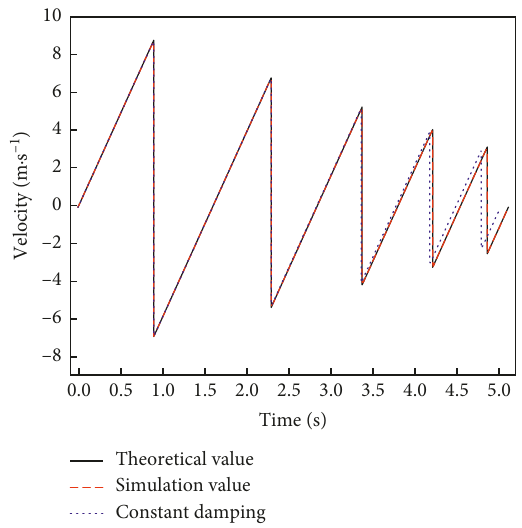
Figure 5: Position of the centroid mass.